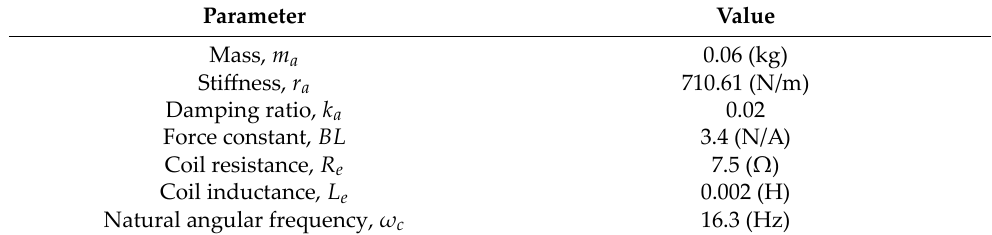
Table 2. Inertial actuator data.